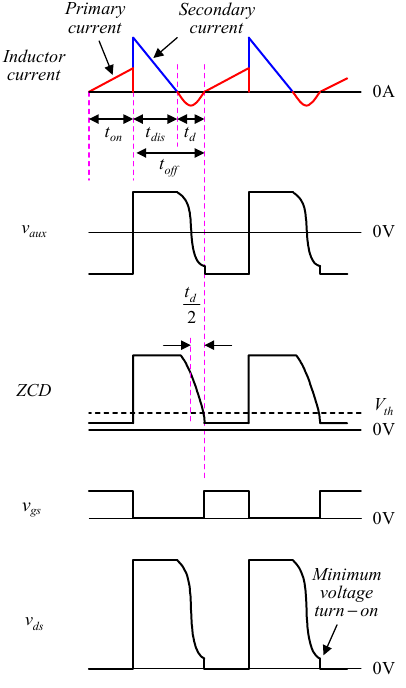
Figure 3. Illustrated waveforms under critical conduction mode (CRM) pulse width modulation (PWM) control.